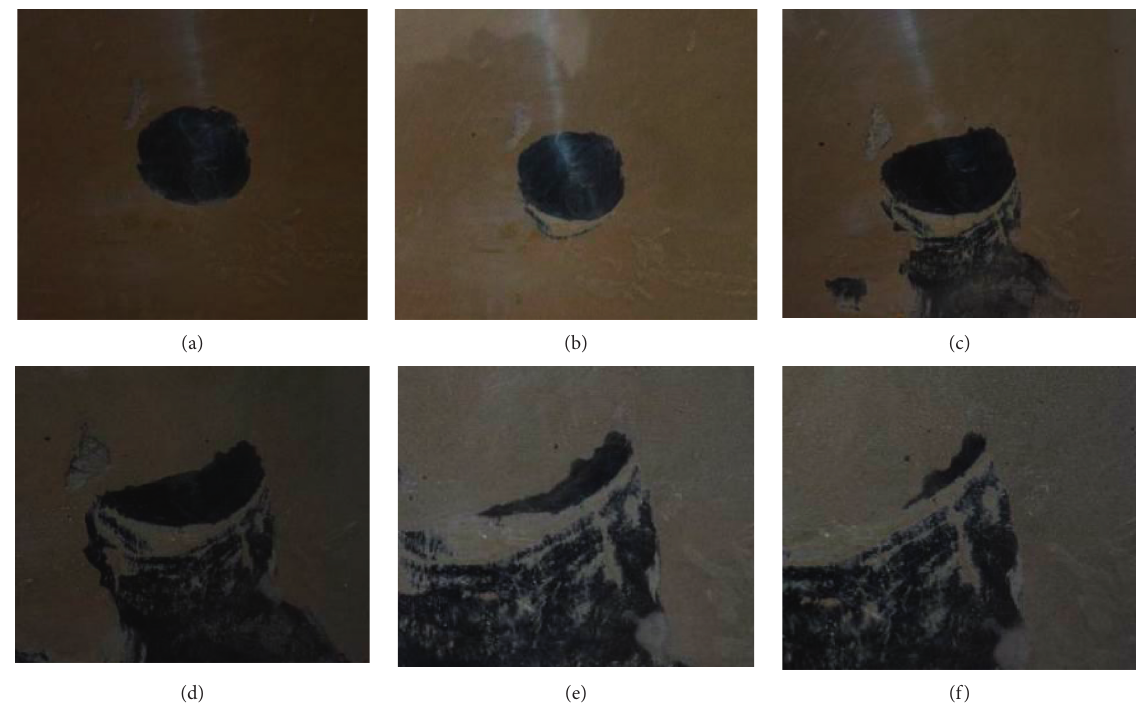
Figure 12: Stratum cavity boundary closure process. (a) Process 1. (b) Process 2. (c) Process 3. (d) Process 4. (e) Process 5. (f) Process 6.